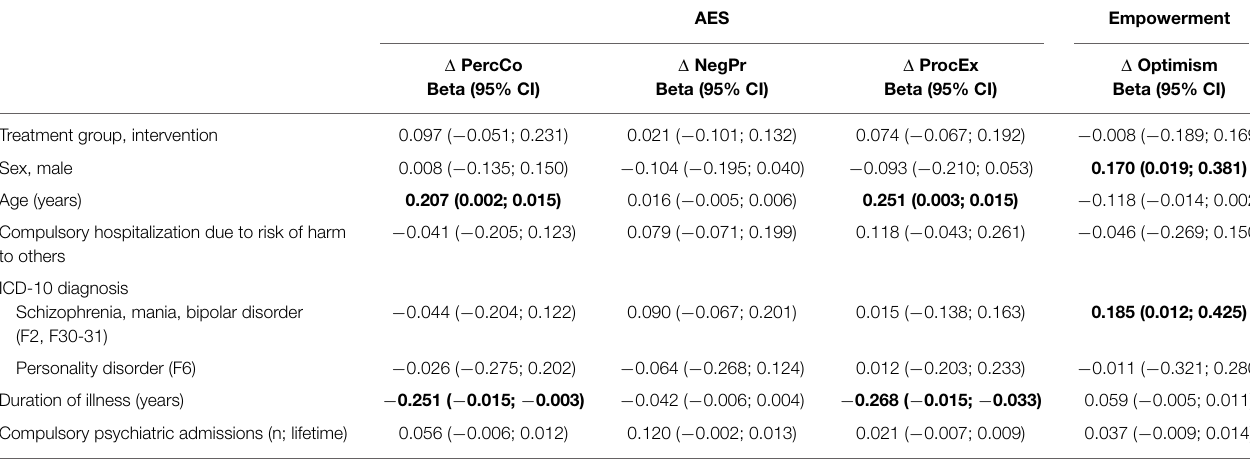
TABLE 3 | Perceived coercion and empowerment: predictors of changes (regression analysis, standardized regression coefficients, and 95% confidence intervals) .